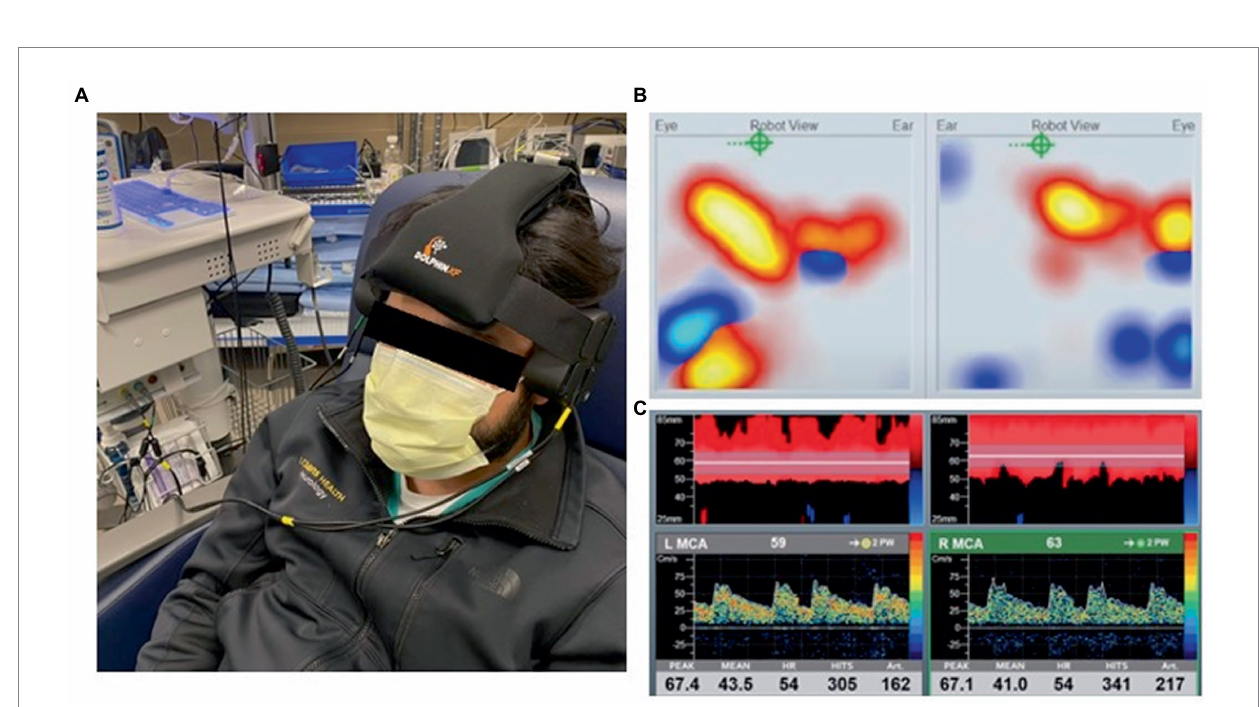
FIGURE 6 (A) Transcranial doppler (TCD) robotic headset placement. (B) Automated robotic scanning for intracranial vessel. (C) Continuous bilateral middle cerebral artery recordings with power M-mode and spectral doppler. Viasonix Dolphin/XF TCD Robotic Probe, Imaging Monitoring United States ®